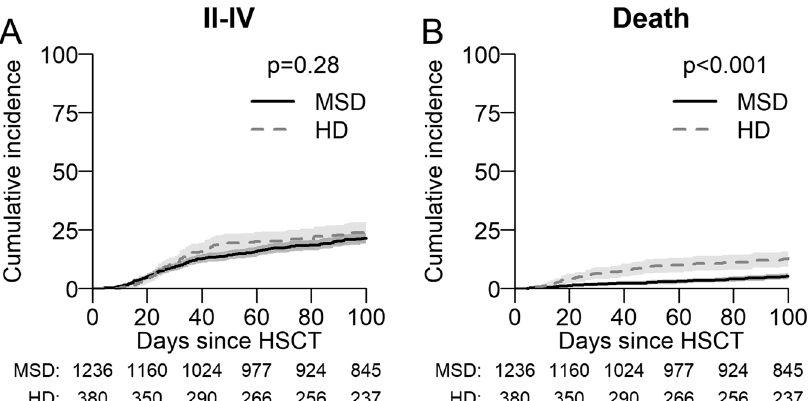
Fig. 2 Cumulative Incidence of aGVHD. A Cumulative incidence of acute Graft Versus Host Disease (aGvHD) grade II – IV. B Cumulative incidence of death due to aGVHD.